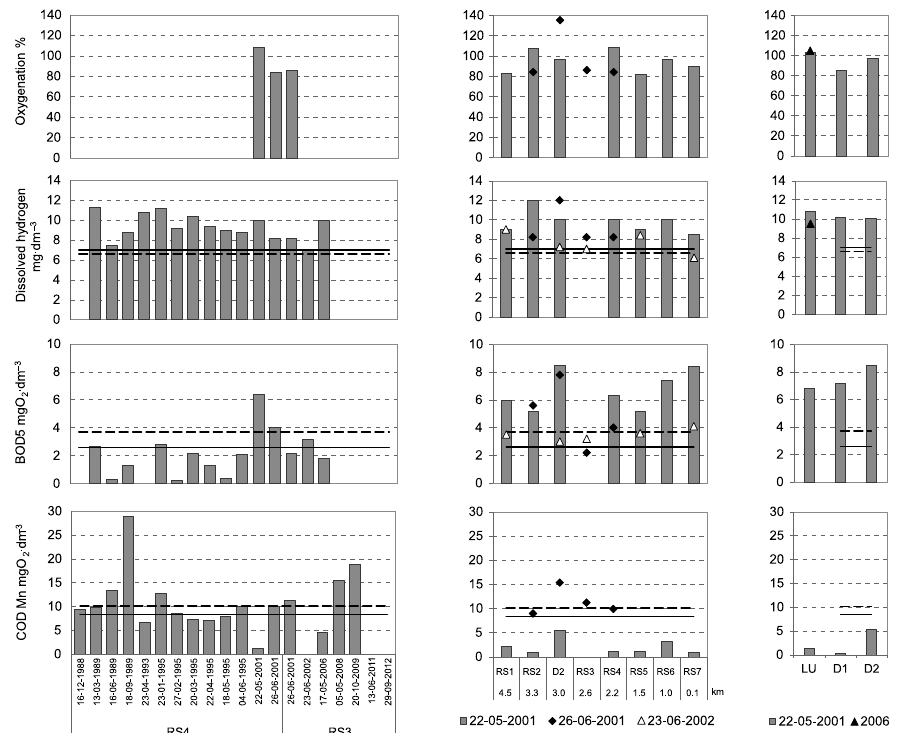
Fig. 7. oxygen indicators of surface waters: oxygenation, dissolved oxygen, biochemical oxygen demand (BOD ) and chemical oxygen demand 5